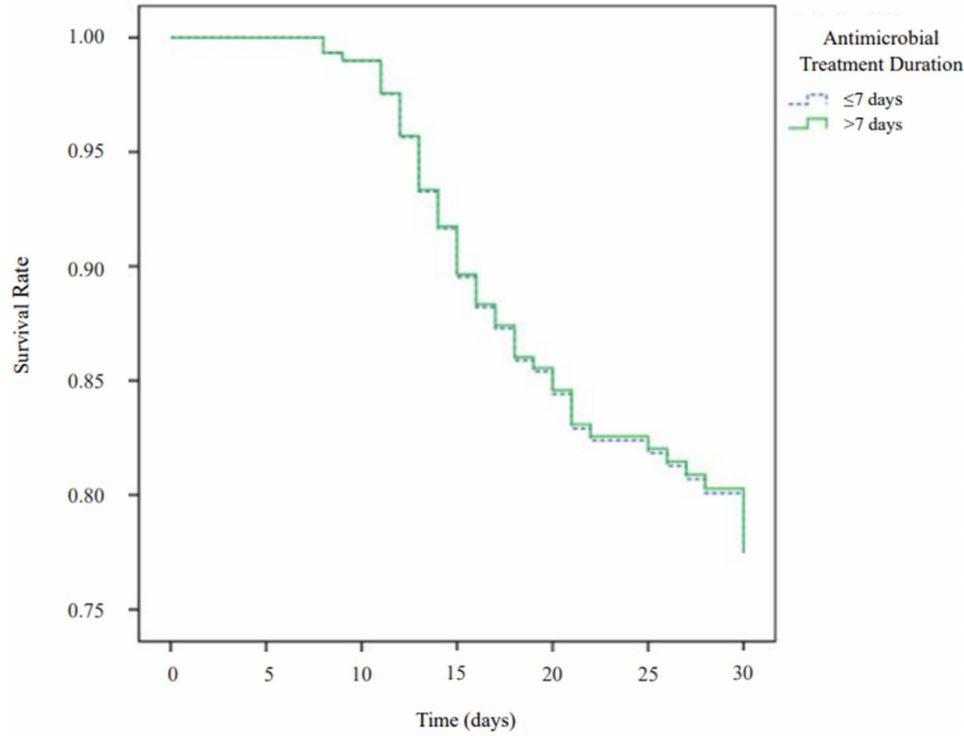
Figure 2. Cox survival analyses comparing 30-day mortality between short- versus long-term therapy for Pseudomonas aeruginosa or Acinetobacter baumannii-calcoaceticus complex bloodstream